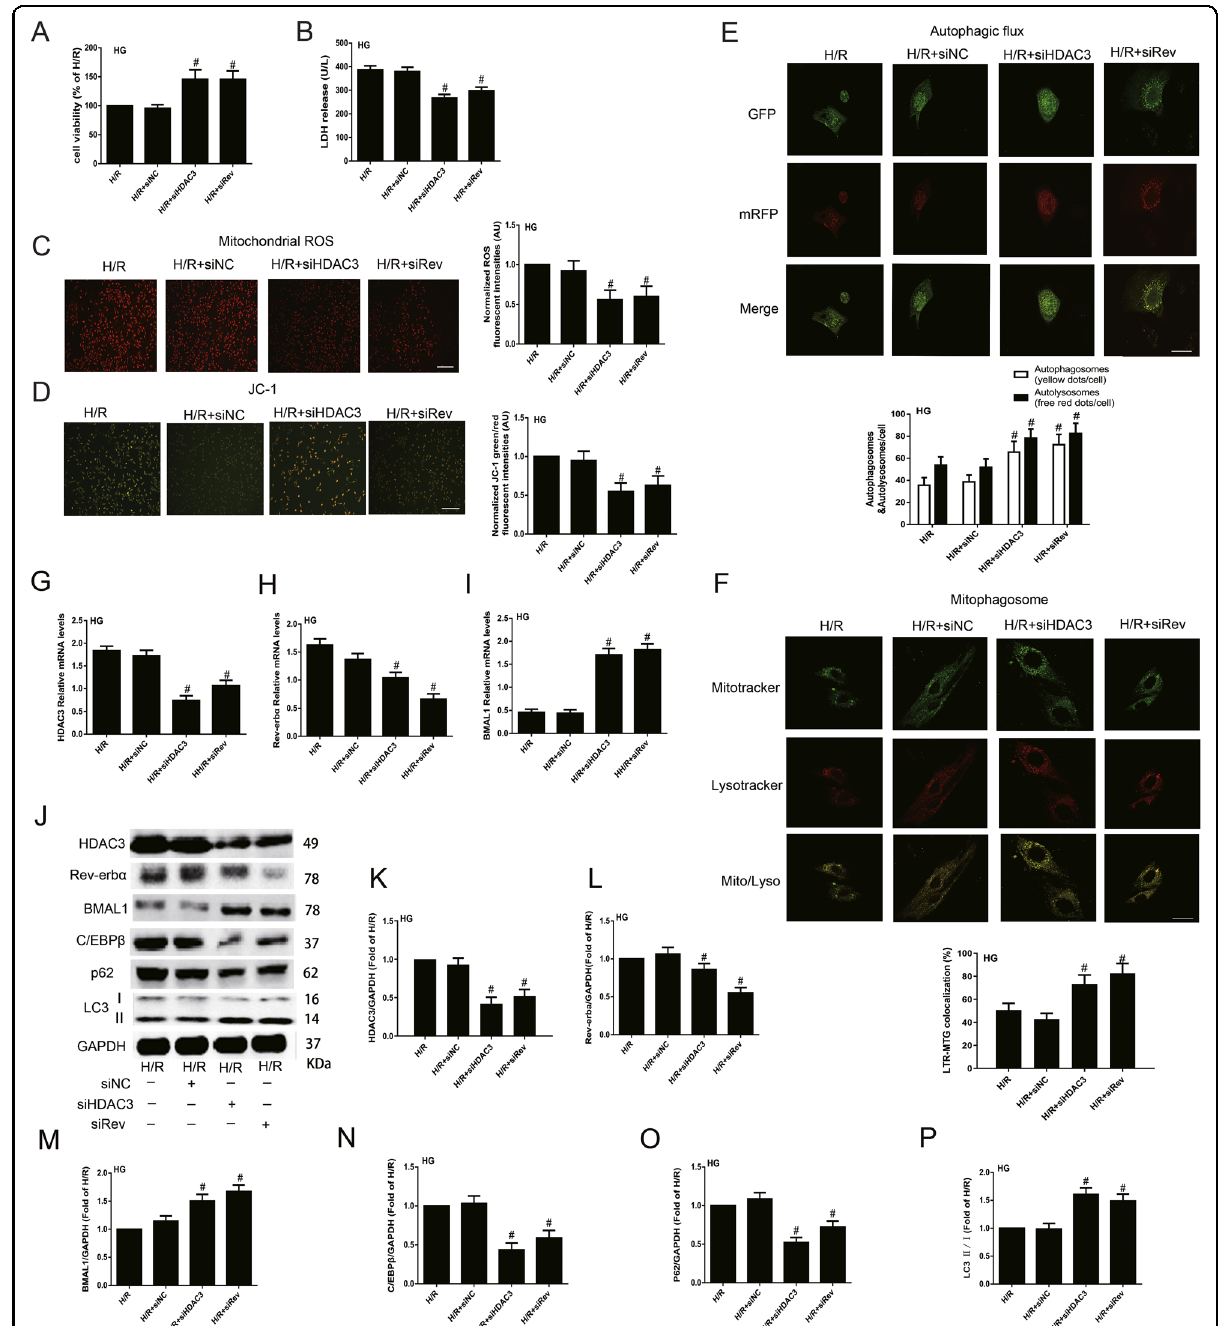
Fig. 6 Knockdown of HDAC3/Rev-erb α expression attenuated neonatal rat cardiomyocytes H/R injury by upregulating BMAL1 expression to activate mitophagy under HG condition. A Cell viability was analysed by CCK-8 kit. B The serum level of LDH was analysed by ELISA kit. C and D Mitochondrial ROS ( C ) and JC-1 ( D ) were detected to analyse mitochondrial function. Scale bar: 100 μ m. E Tandem fl uorescent mRFP-GFP-LC3 adenovirus was used to detect autophagic fl ux. Scale bar: 20 μ m. F MitoTracker Green and LysoTracker Red staining were used to detect mitophagosome formation. Scale bar: 20 μ m. G – I The mRNA levels of HDAC3 ( G ), Rev-erb α ( H ), and BMAL1 ( I ) were analysed by qPCR. J – P The protein levels of HDAC3 ( K ), Rev-erb α ( L ), BMAL1 ( M ), C/EBP β ( N ), P62 ( O ), and LC3 II/I ( P ) were analysed by western blotting in the cultured neonatal rat cardiomyocytes. n = 6 per group. # P < 0.05 versus